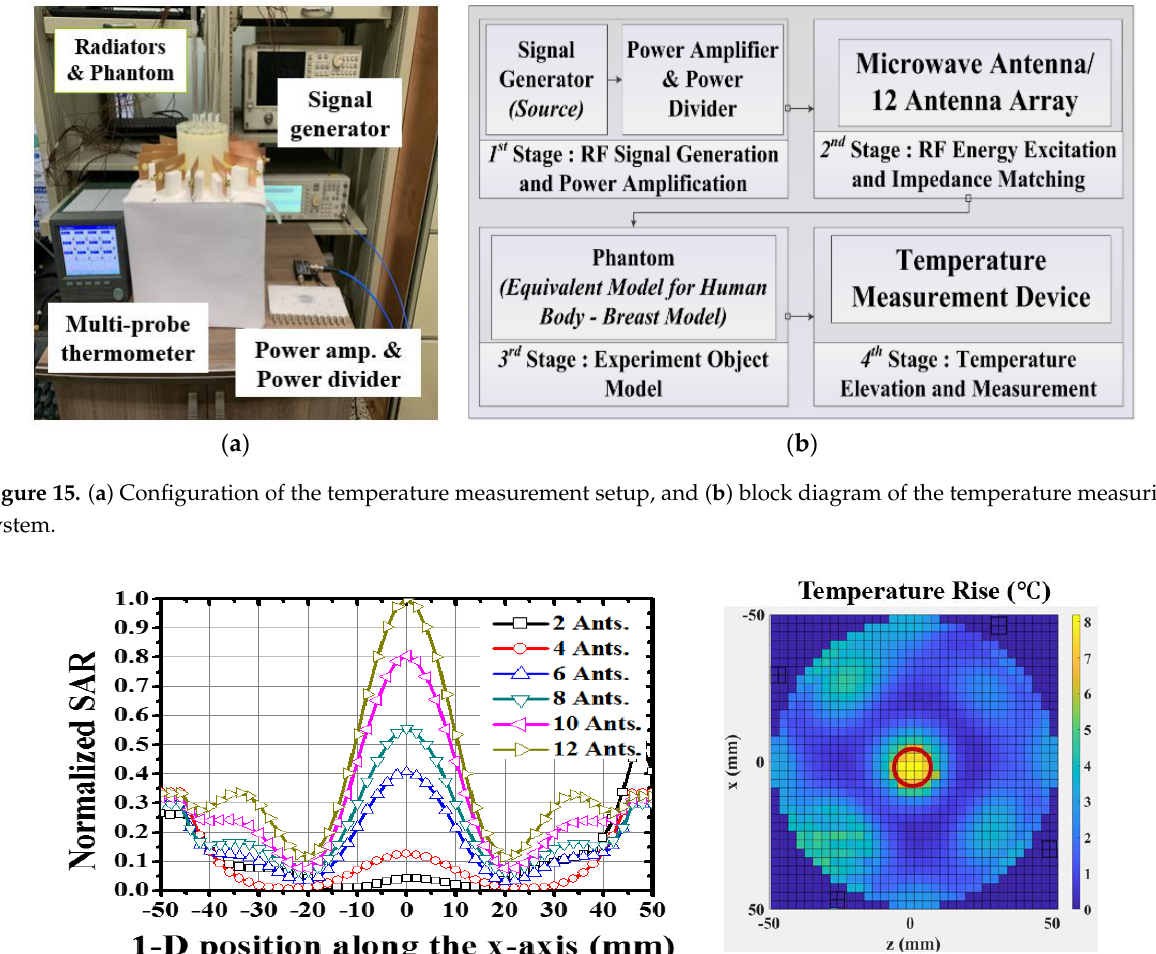
Figure 16. ( a ) Comparison of normalized SAR in terms of the number of antennas along the x-axis of the breast phantom,